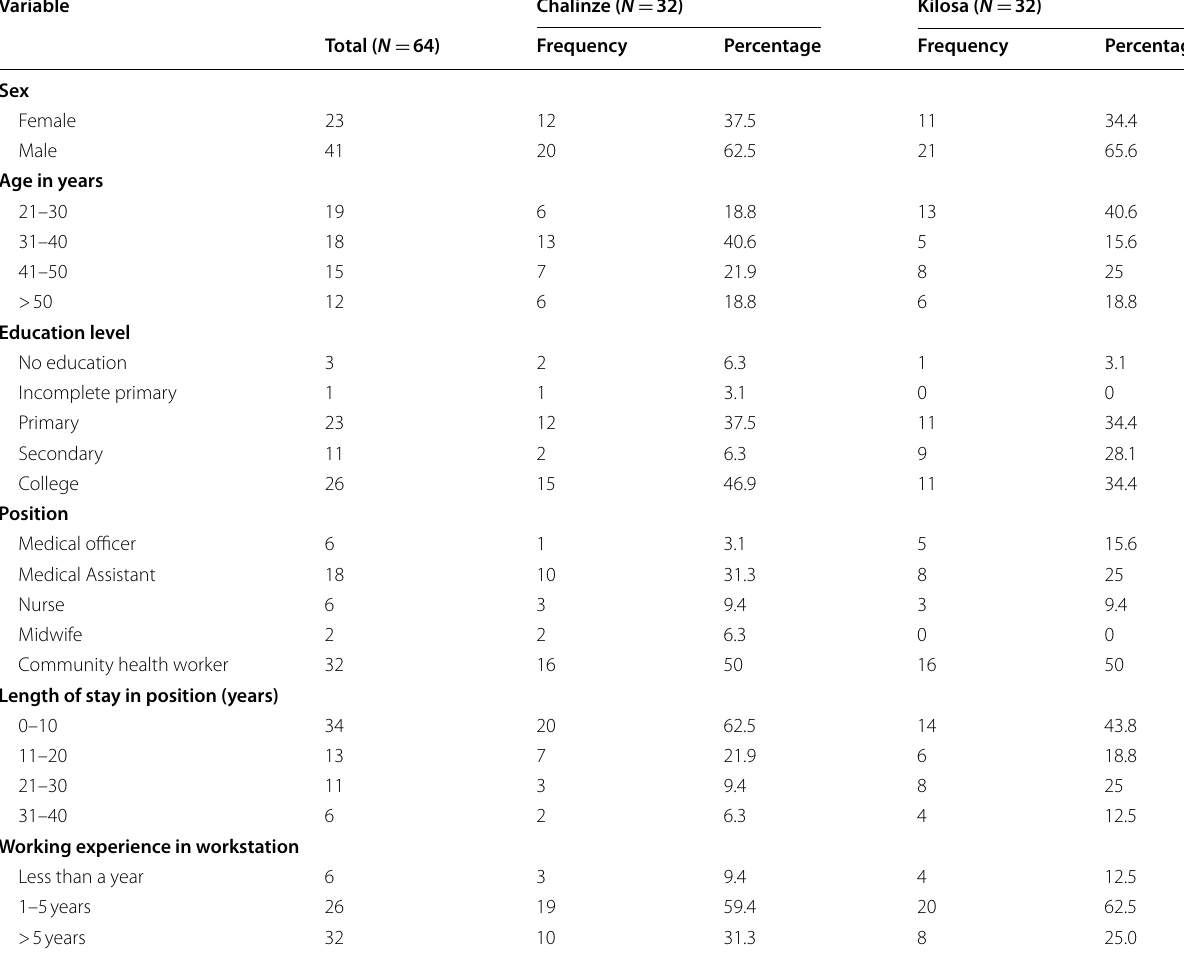
Table 1 Participant’s socio demographic characteristics in Kilosa and Chalinze